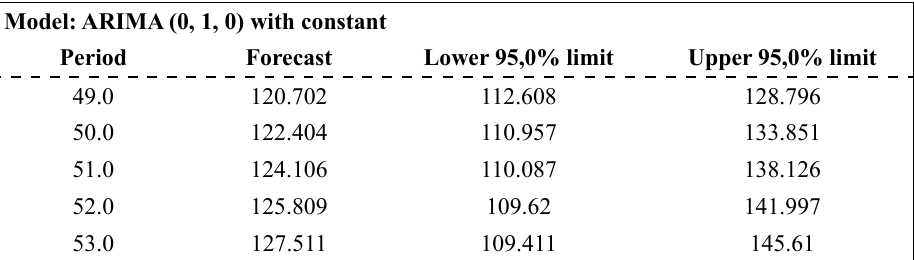
Table 5. ARIMA (0,1,0)